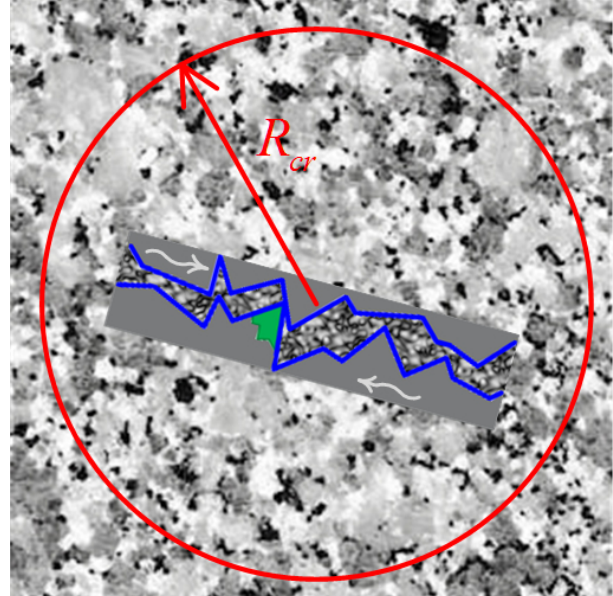
Fig. 2. A fault (blue lines) is embedded in a heterogeneous envi- ronment. The EQ preparation process at the first stage concerns the fracture of a disordered medium surrounding over a critical circle (Bowman et al., 1998; Sammis and Sornette, 2002) the major fault emitting theMHz EME which can be described by means of a phase transition of second order. The symmetry breaking signalizes the transition from the phase of non-directional, almost symmetrical, cracking distribution to a directional localised cracking zone along the direction of the fault. The EQ is inevitable if and only if the as- perities break (green highlighted area), emitting thekHz EME dur- ing the second stage, and then an EME silence